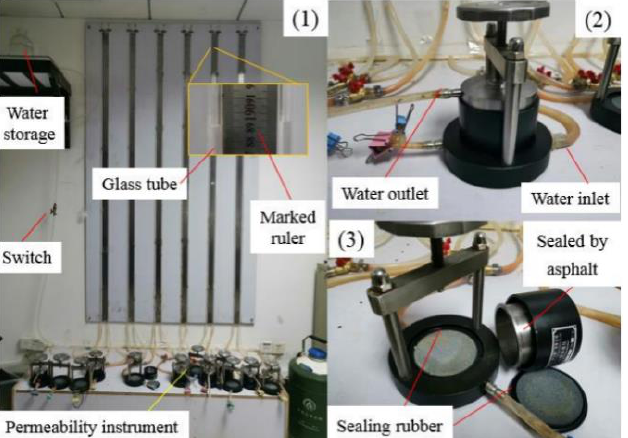
Figure 6. Permeability instruments: (1) Overall drawing of test equipment; (2) Permeameter; (3) Seal- ing method of